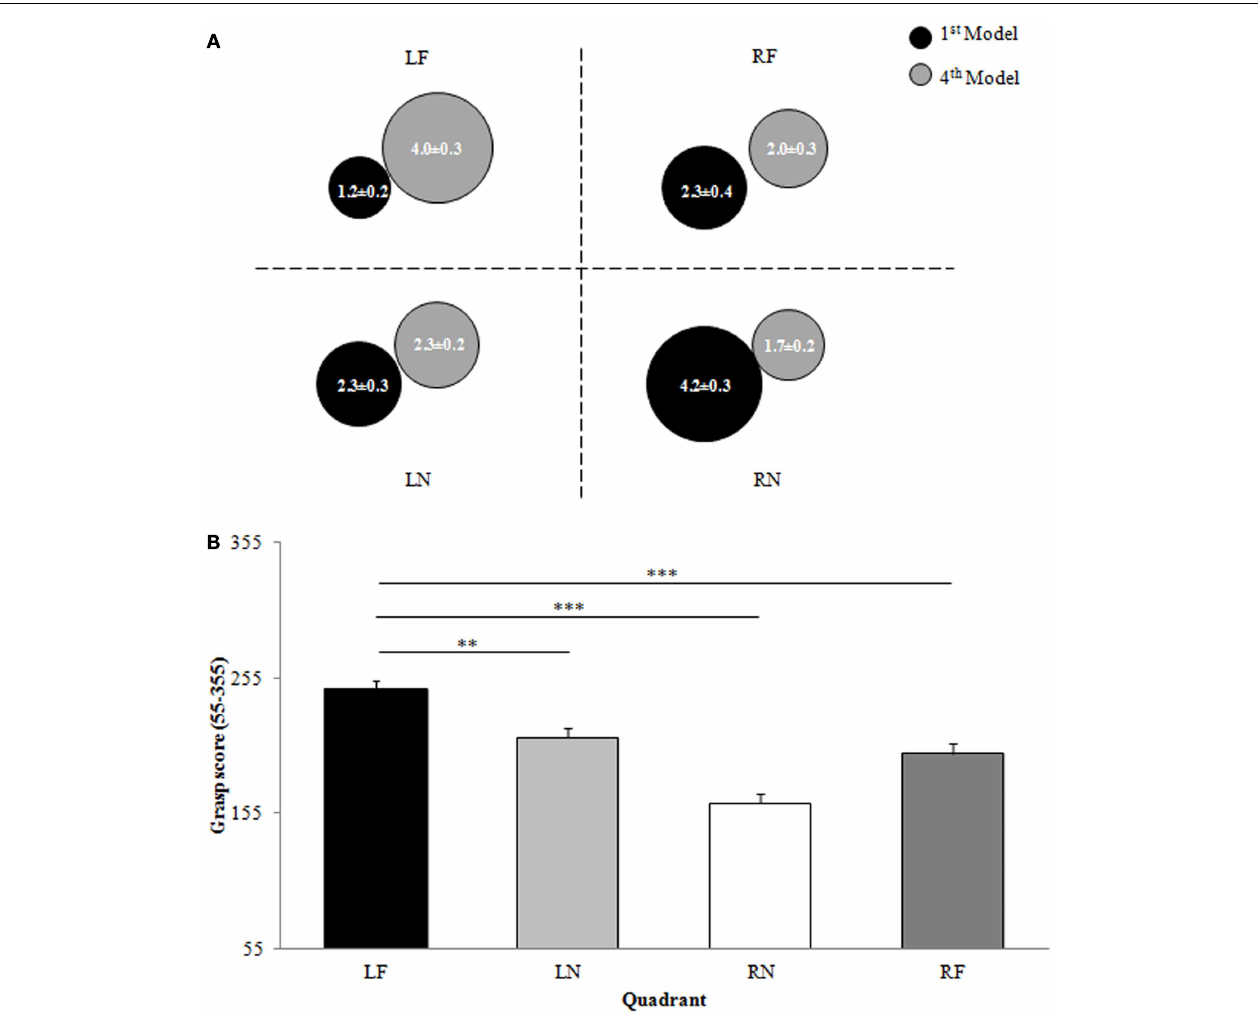
errors. (B) Overall grasp score for each quadrant of space. Data are means and standard errors. LF, left far; LN, left near; RN, right near; RF, right far. * p < 0.05, ** p < 0.01, *** p < 0.001 with respect to